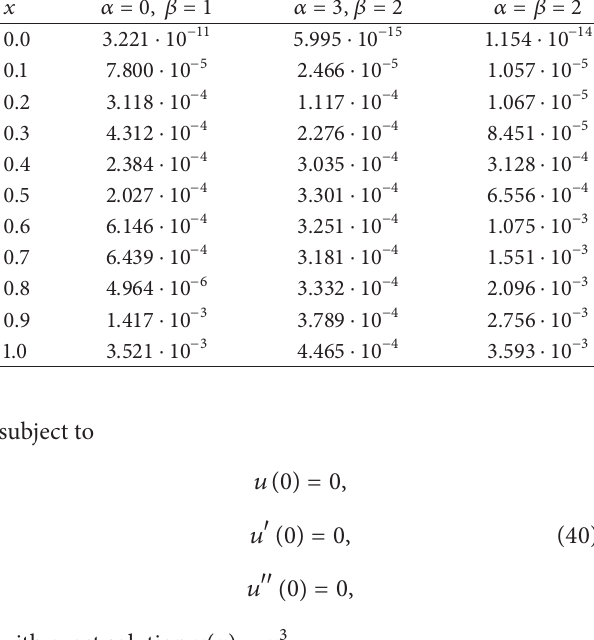
Table 2: Absolute errors using MGLC method at 𝑁 = 22 for Example